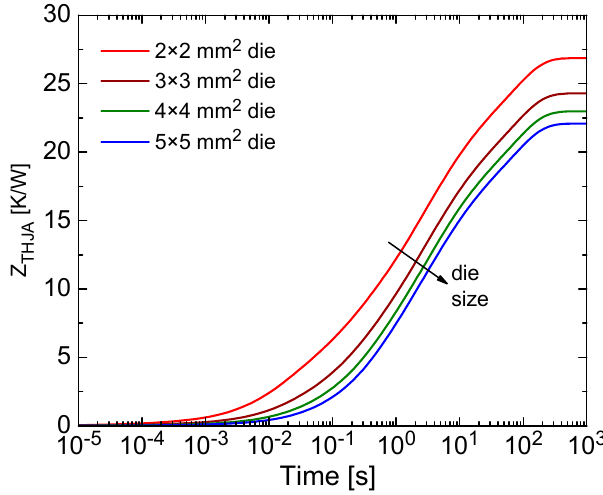
Figure 6. Thermal impedance Z THJA vs. time of a 10 × 10 mm 2 eTQFP with a 6 × 6 mm 2 epad for four different die sizes.